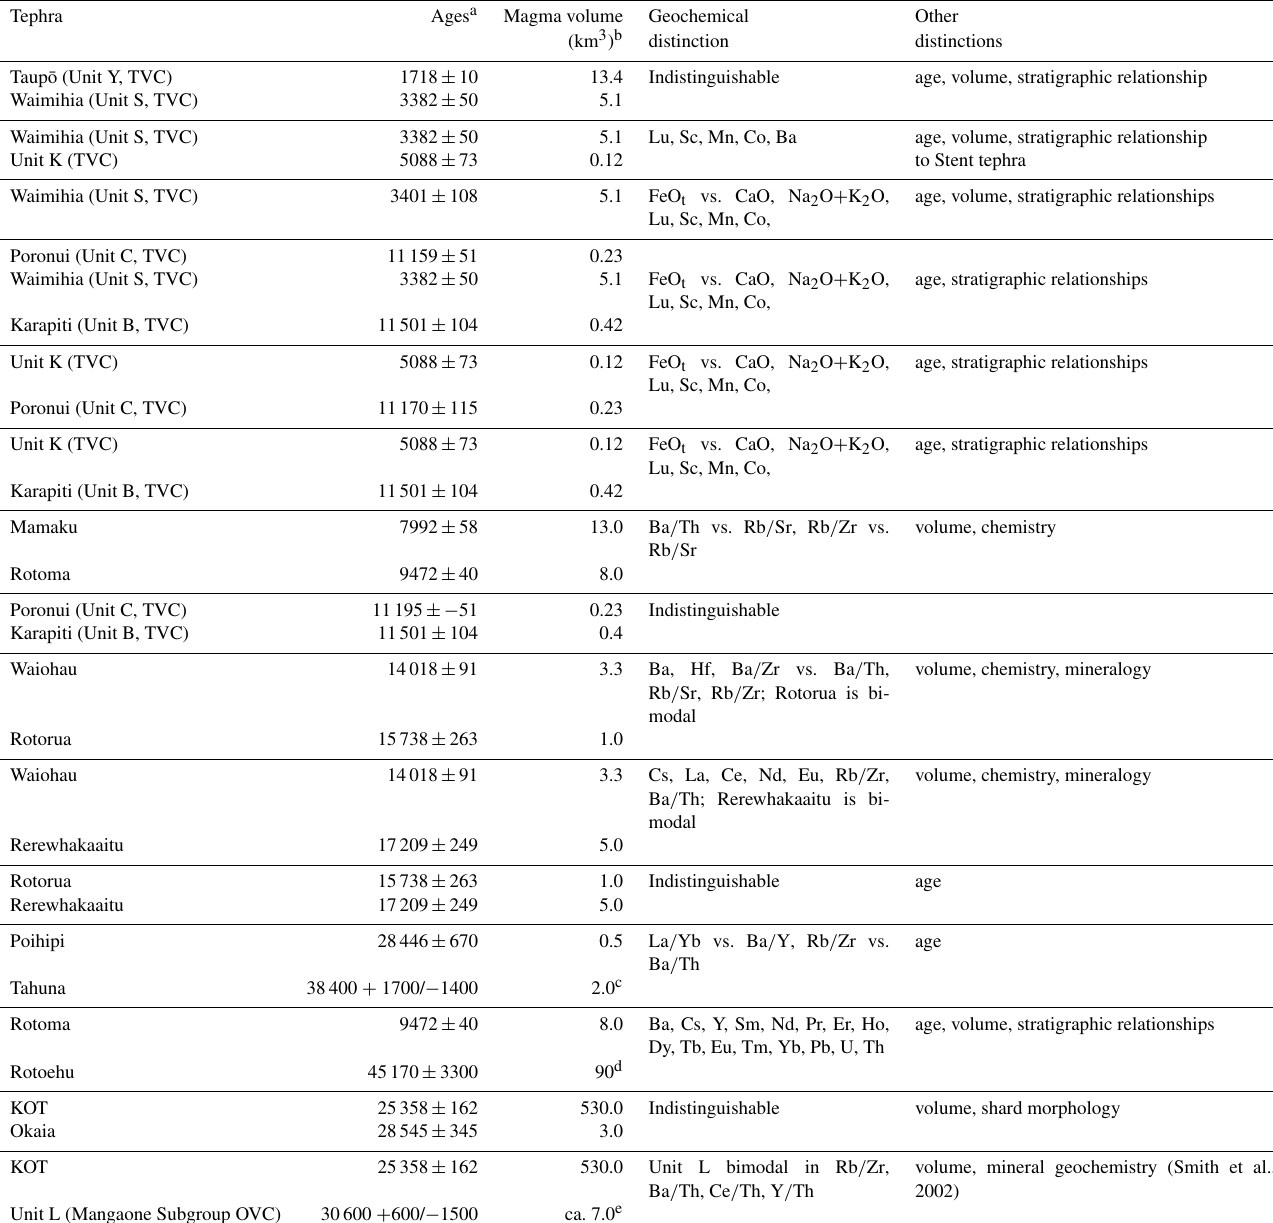
Table 4. Geochemically similar tephra and the identified distinctions from this research.